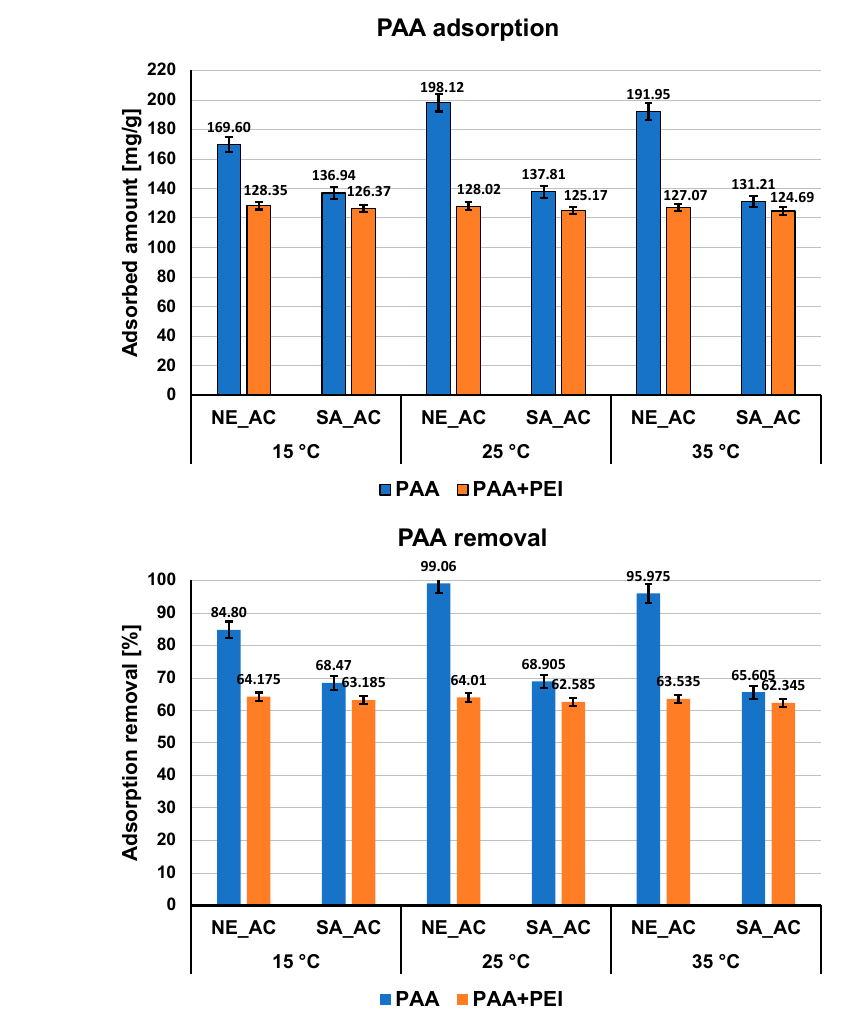
Figure 2. PAA adsorbed amounts ( a ) and its percentage removal ( b ) from the activated carbons surface in single and mixed systems of adsorbates at three examined temperatures, pH 3.